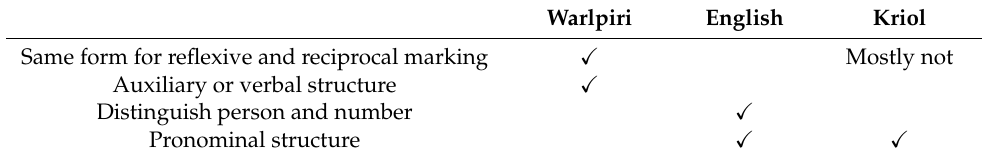
Table 3. Summary of reflexive and reciprocal structures in the source languages of Light